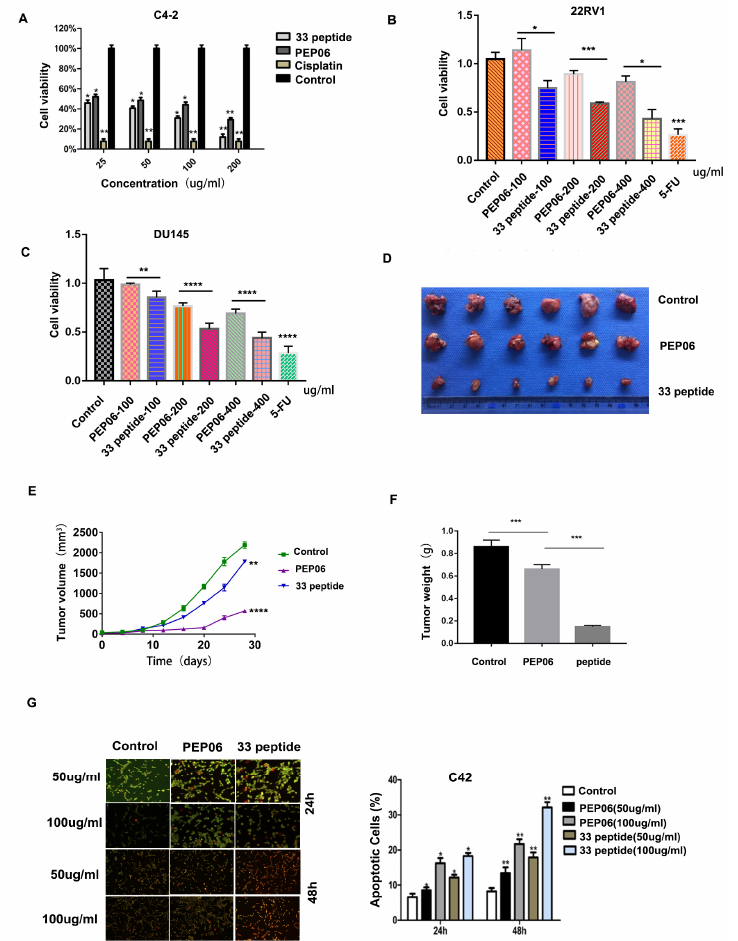
Figure 2. ( A ): MTT assay performed to detect the activity of C4-2 cells after 24 h treatment with 33 polypeptide (25, 50, 100 or 200 µ g/mL), PEP06 (25, 50, 100 or 200 µ g/mL), cisplatin (10 µ g/mL) and 5% glucose solution. ( B , C ): MTT assay was performed to detect the activity of 22RV-1 and DU145 cells after 24 h treatment with 33 polypeptide (100, 200, or 400 µ g/mL), PEP06 (100, 200 or 400 µ g/mL), 5-fluorouracil (10 µ g/mL) and 5% glucose solution. ( D ): Mouse subcutaneous tumorigenesis images of C4-2 cells after 24 h treatment with 33 polypeptide (50 µ g/mL), PEP06 (50 µ g/mL) and 5% glucose saline (n = 6 in each group). ( E ): Tumor volume measurement results of the 33 polypeptide group, PEP06 group and 5% glucose saline group. ( F ): Tumor weight measurement results of the 33 polypeptide group, PEP06 group and 5% glucose saline group, respectively. ( G ): AO/EB double fluorescent staining was used to detect the apoptosis of C4-2 cells of 33 polypeptide (50 µ g/mL and 100 µ g/mL) group, PEP06 (50 µ g/mL and 100 µ g/mL) group and 5% glucose saline group after treatment for 24 h and 48 h, respectively. (*, **, *** and **** stand for p value < 0.05, 0.01, 0.001 and 0.0001,